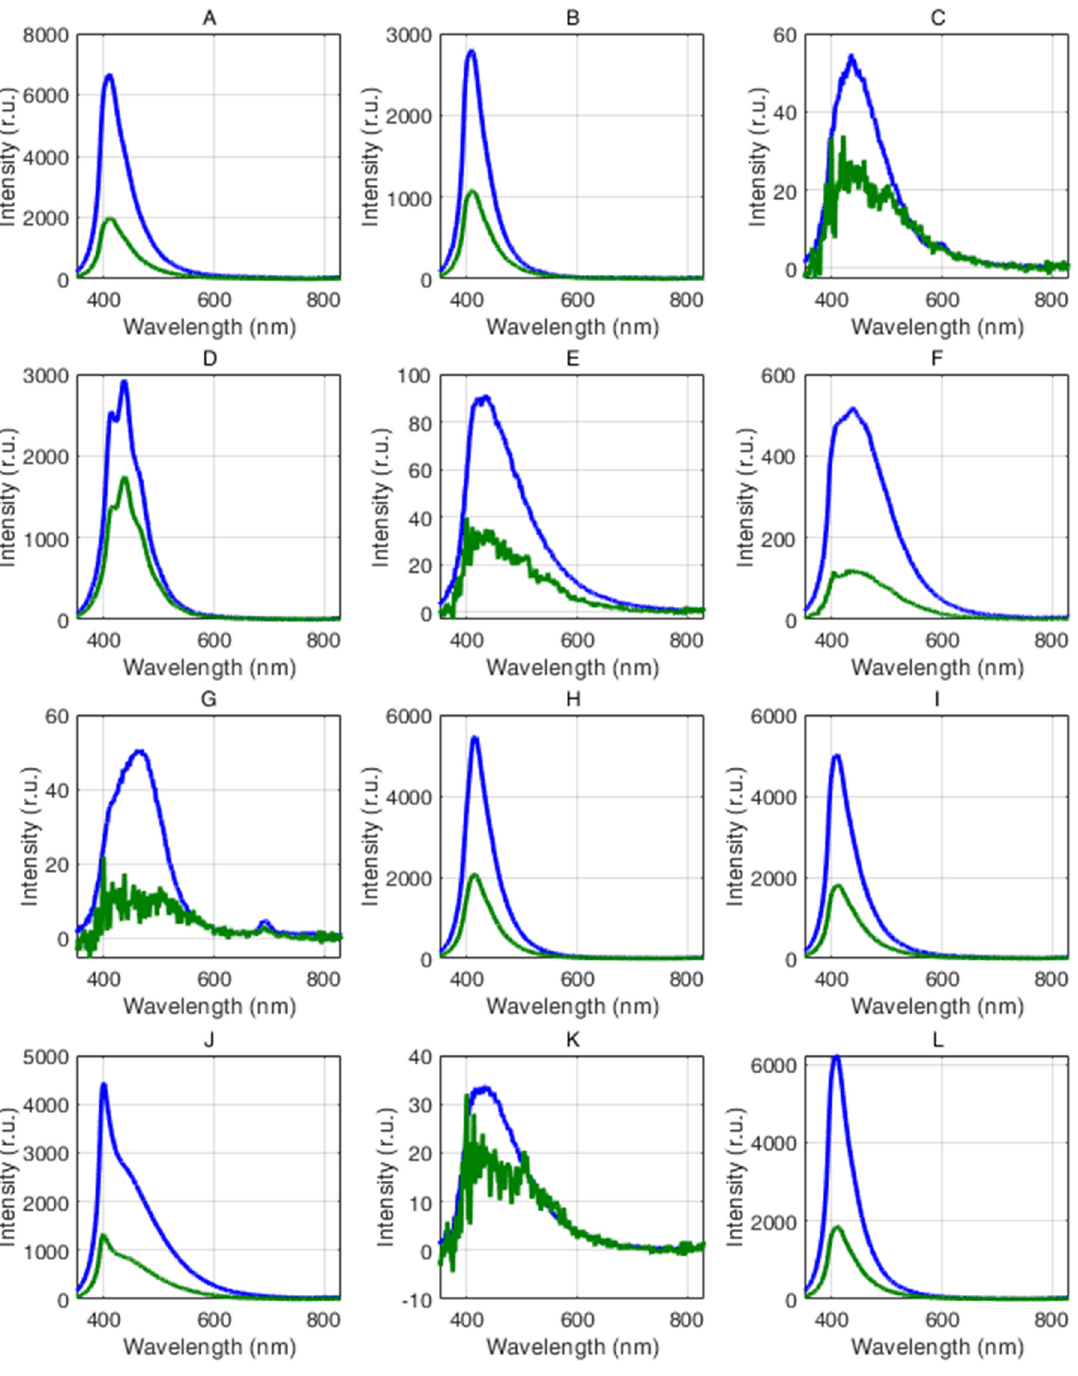
Figure 6. Corrected fluorescence spectra retrieved from the spectra acquired on the wet samples (green lines) and the corresponding spectra acquired on the dry samples (blue lines): ( A ) transparent PET bottle, ( B ) blue PET bottle, ( C ) surgical mask, ( D ) transparent blister, ( E ) white plastic bag, ( F ) white bottle cap, ( G ) blue bottle cap, ( H ) white bottle, ( I ) fresh fruit container, ( J ) latex glove, ( K ) transparent packaging, ( L ) transparent plastic glass.